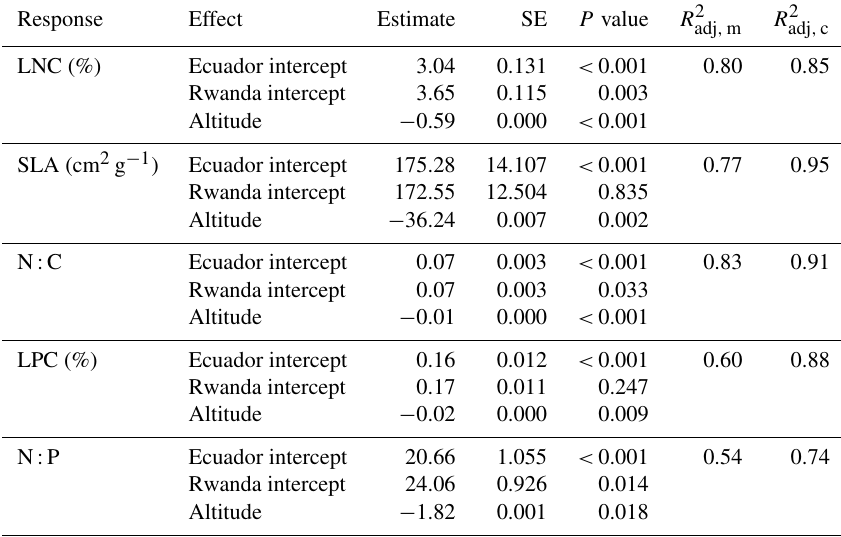
Table 2. Fixed effects estimates (altitude in kma.s.l.) for the different canopy-level response variables; leaf nitrogen content (LNC), inverse C : N ratio, specific leaf area (SLA), leaf phosphorus content (LPC) and N : P ratio, along with the estimated marginal (m) and conditional (c) R 2 (sensu Nakagawa and Schielzeth, 2013). The interaction term for altitude × transect was not significant in any case, and was hence adj not retained in any model.